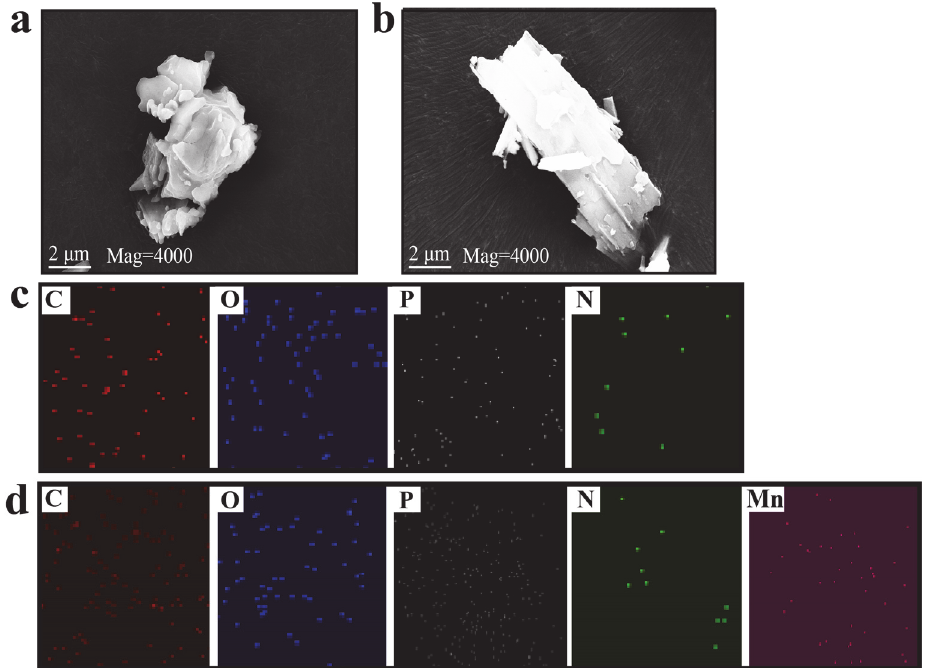
Figure 3. SEM images of HP ( a ) and HP-Mn ( b ); EDS mapping of HP ( c ) and HP-Mn ( d ).